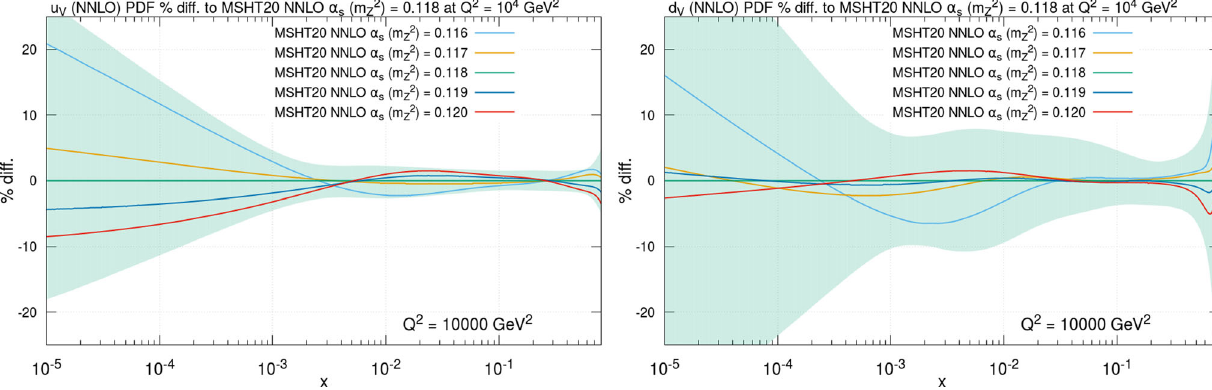
Fig. 9 Percentage difference in the NNLO up valence and down valence quark PDFs at Q 2 = 10 4 GeV 2 relative to the central (α S ( M 2 set for fits with different values of α S . The percentage error bands for the central set are